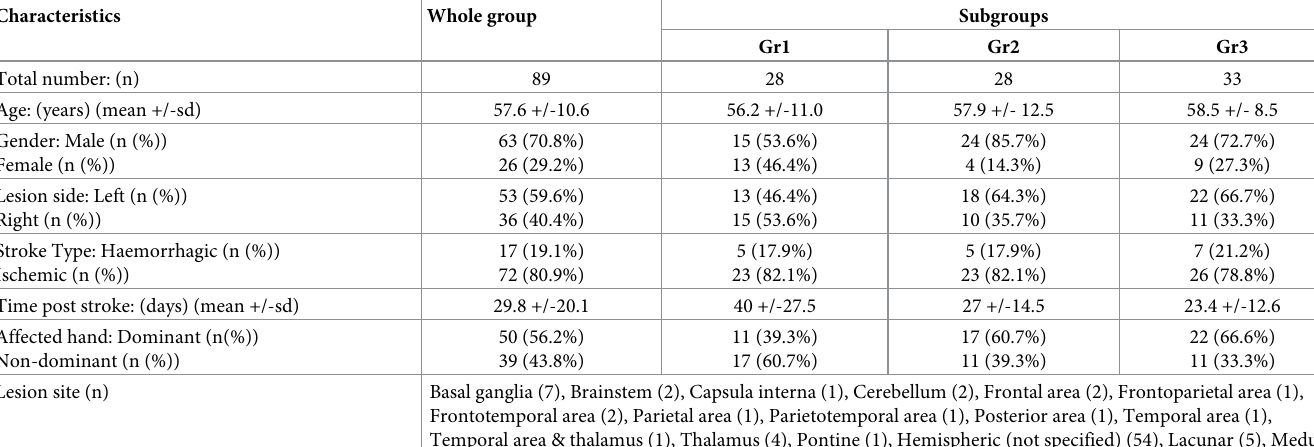
Table 1. Overview of patient characteristics at